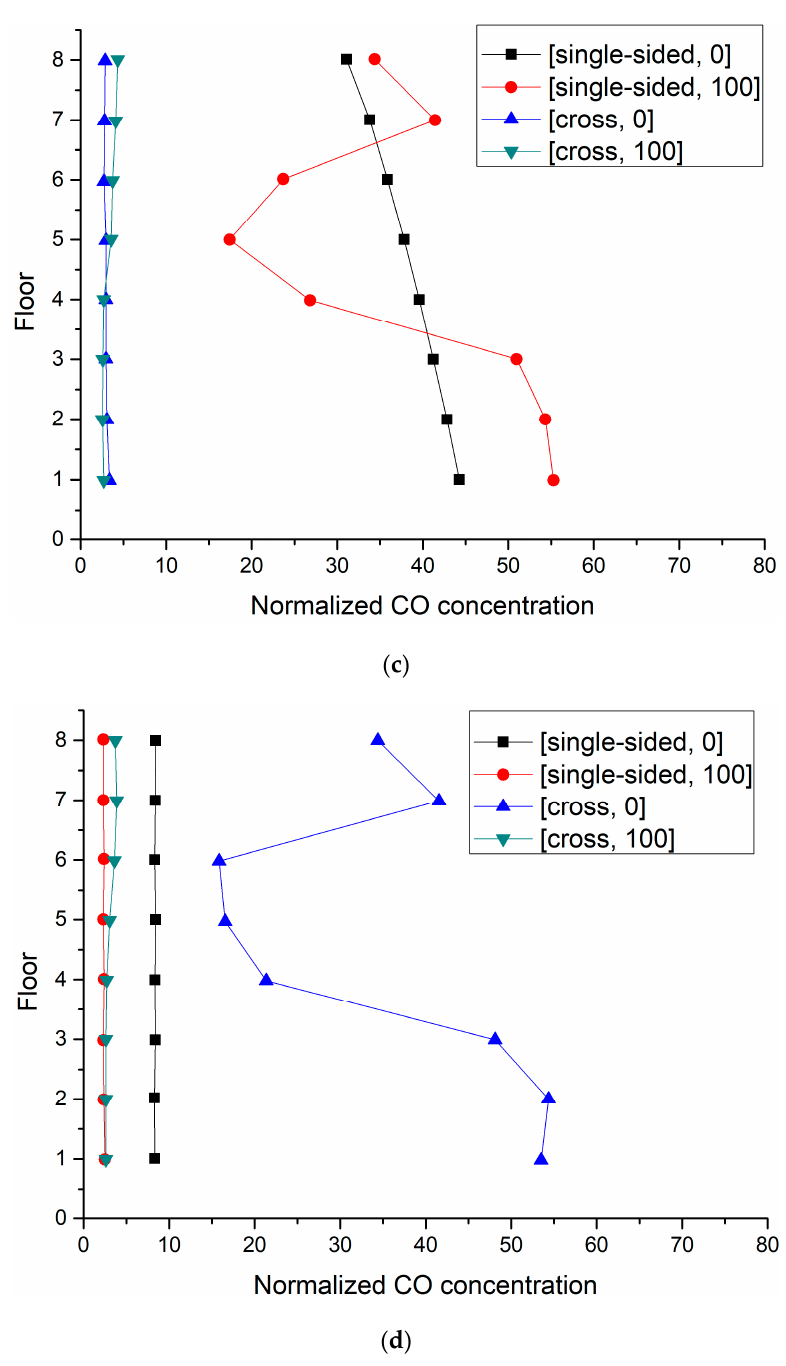
Figure 7. Normalized CO concentration at different floors in ( a ) windward side of Building 1, ( b ) leeward side of Building 1, ( c ) windward side of Building 2, and ( d ) leeward side of Building 2.